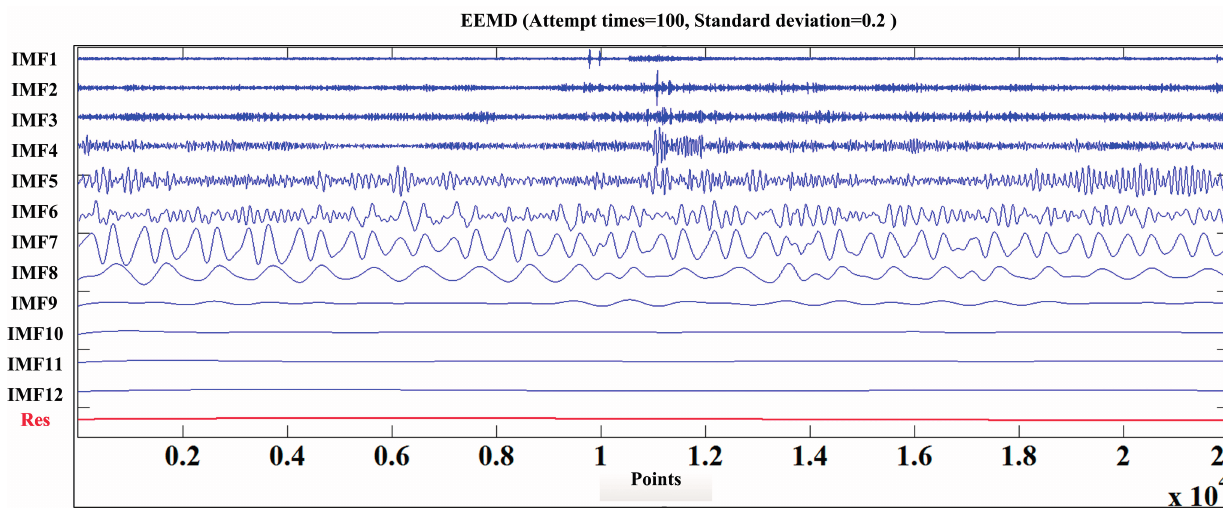
Figure 5. The decomposition result of